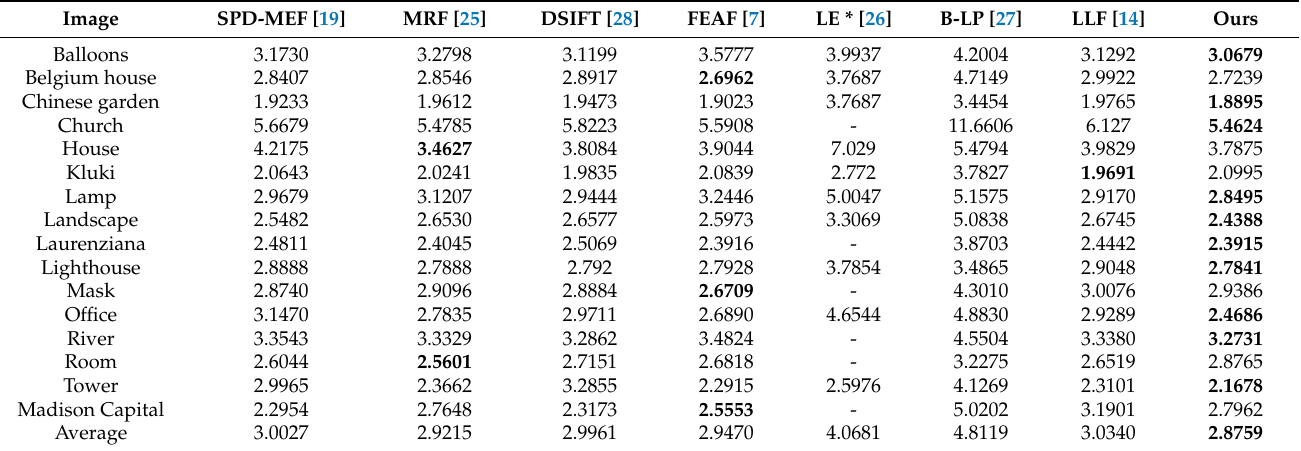
Table 4. Comparison of image quality assessment (NIQE) with existing MEF techniques.